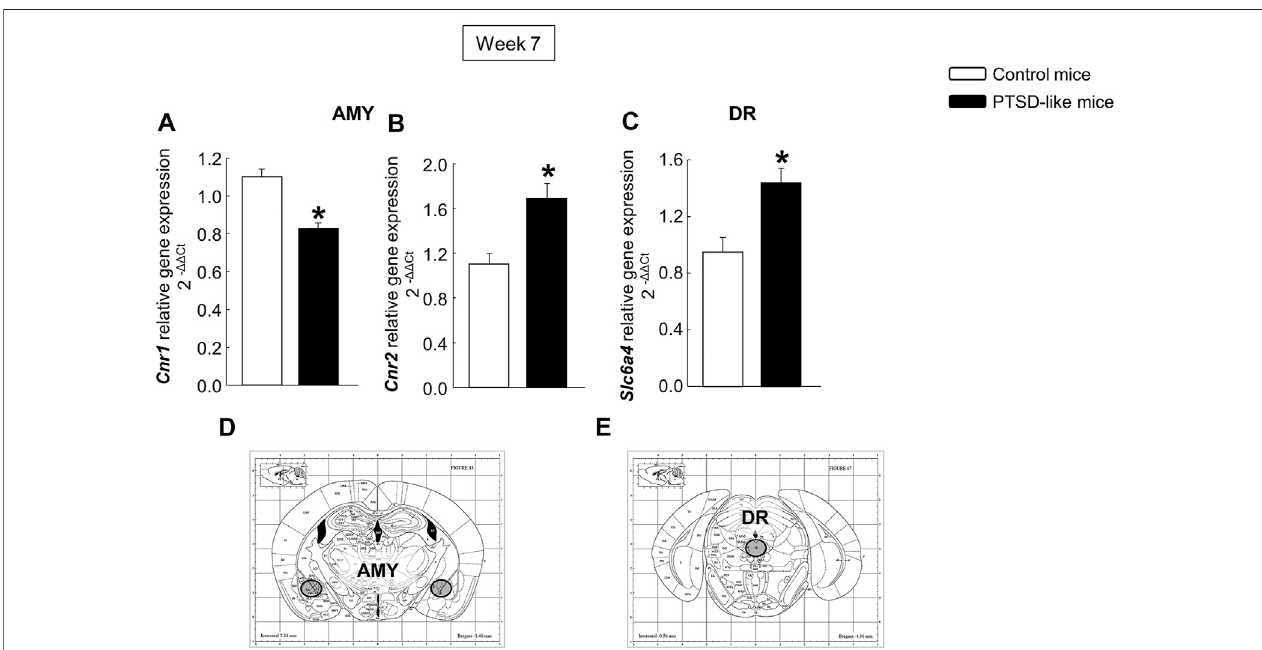
FIGURE 4 | Relative gene expression analyses of cannabinoid receptors 1 ( Cnr1 ) (A) and 2 ( Cnr2 ) (B) in the amygdala (AMY), and serotonin transporter ( Slc6a4 ) in the dorsal raphe nucleus (DR) (C) by real time PCR. Columns represent the mean and vertical lines ± SEM of 2 − ΔΔ C . *, Values from PTSD-like mice that are signi fi cantly differentfromcontrolmice(Student ’ s t -test, p < 0.001).MiceexposedtothePTSD-likemodel:N (cid:2) 8;controlmice:N (cid:2) 8. (D,E) Representativeimagesfrom Paxinosand Franklin ’ s mouse brain atlas including the selected coronal sections to microdissect the regions of